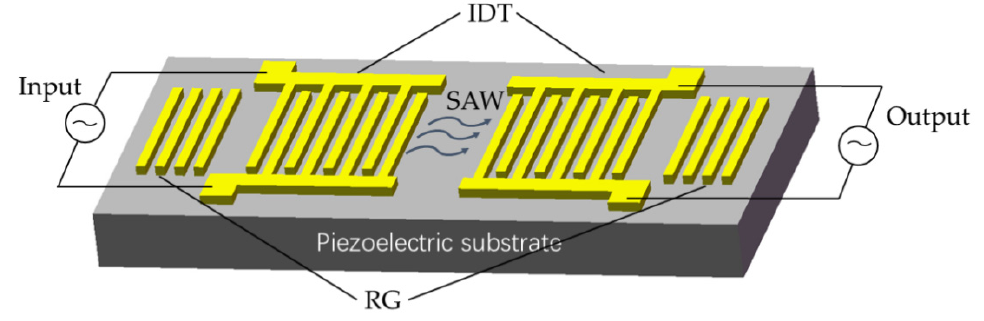
Figure 1. Basic structure of the SAW device [4] .